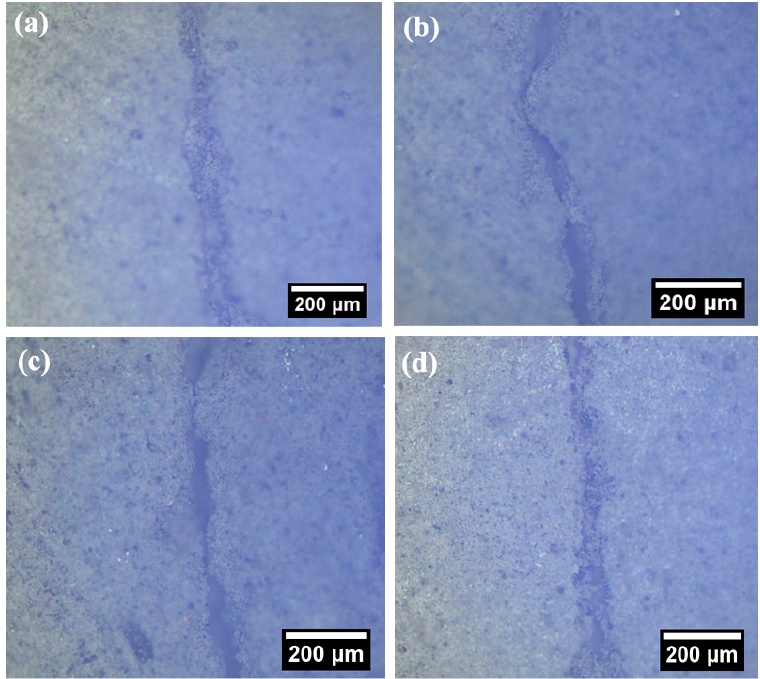
Figure 4. Stereomicrograph at the crack for the samples ( a ) S1 ( b ) S2 ( c ) S3 ( d ) S4.